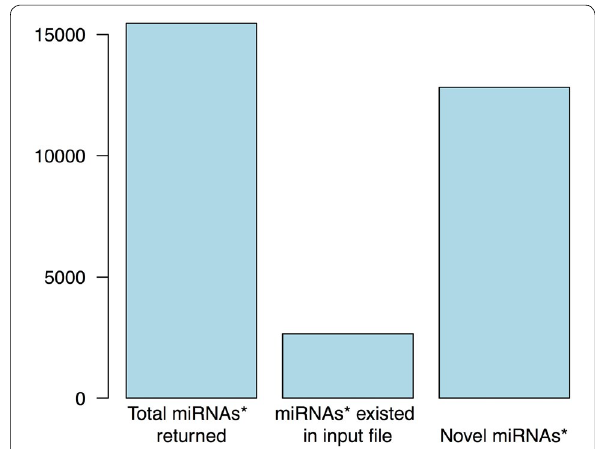
Fig. 5 Evaluation of the output of running StarSeeker on plant sequences from miRBase. Of the 15,468 sequences that existed in the output file, 2650 were matched with the initial source mature miRNA data and 12,818 are considered novel miRNAs* and their existence can be verified by RNA-Seq experiments